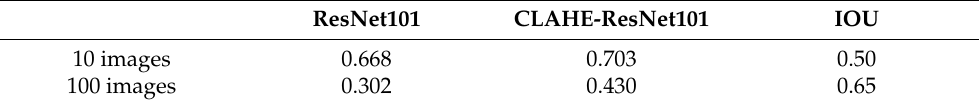
Table 1. The mAP values of network prediction before and after adding CLAHE.